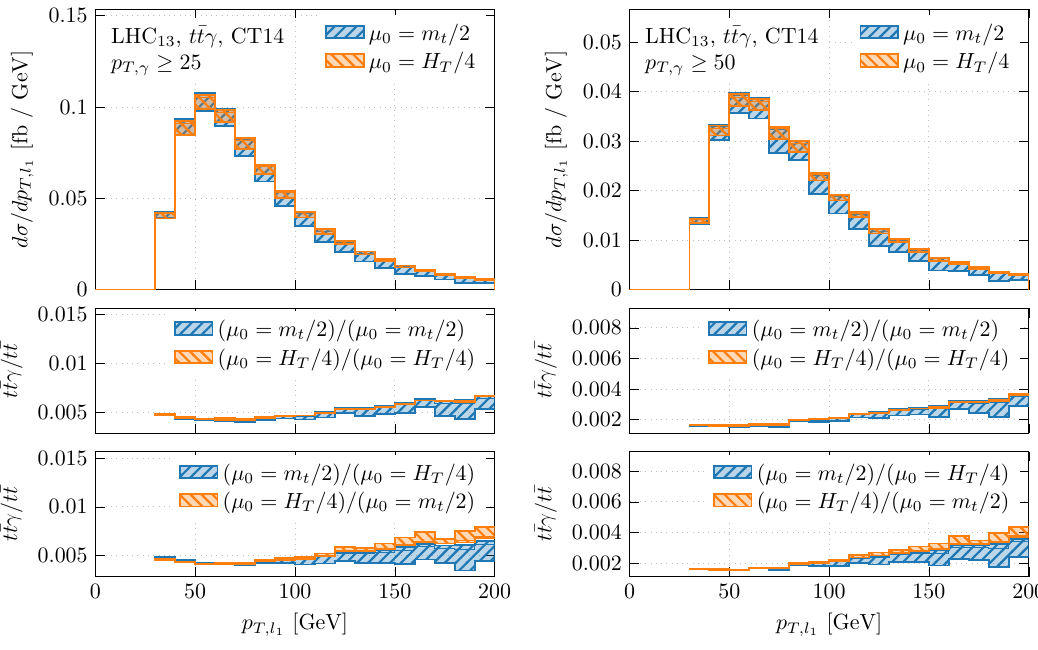
Figure 7 . Di(cid:11)erential cross section distributions as a function of the transverse momentum of the hardest charged lepton for the pp e + (cid:23) e (cid:22) (cid:0) (cid:22) (cid:23) (cid:22) b (cid:22) b(cid:13) + X process at the LHC run II with p s = 13 TeV. ! The upper plots show absolute NLO predictions for p T;(cid:13) > 25 GeV (left panel) and p T;(cid:13) > 50 GeV (right panel) together with the corresponding uncertainty bands resulting from scale variations. Renormalisation and factorisation scales are set to the common value (cid:22) R = (cid:22) F = (cid:22) 0 where (cid:22) 0 = m t = 2 and H T = 4. The CT14 PDF sets are employed. The lower panels display di(cid:11)erential cross section ratios together with their uncertainty bands. In the (cid:12)rst case (middle panel), the same (cid:12)xed (dynamical) scale choice is employed in the numerator and the denominator of the cross section ratio. In the second case (bottom panel), di(cid:11)erent scale choices in the numerator and in the denominator have been